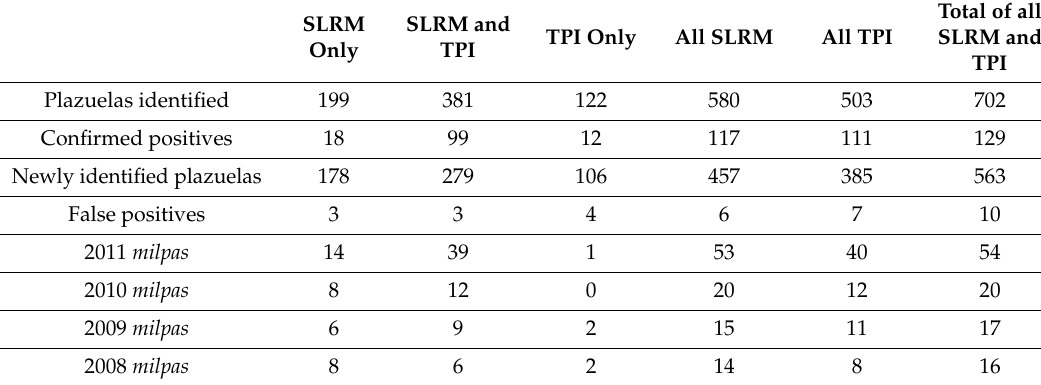
Table 2. Detailed comparisons of results from only SLRM, only TPI, and both SLRM and TPI, as well as all plazuelas identified with SLRM and TPI (see Table